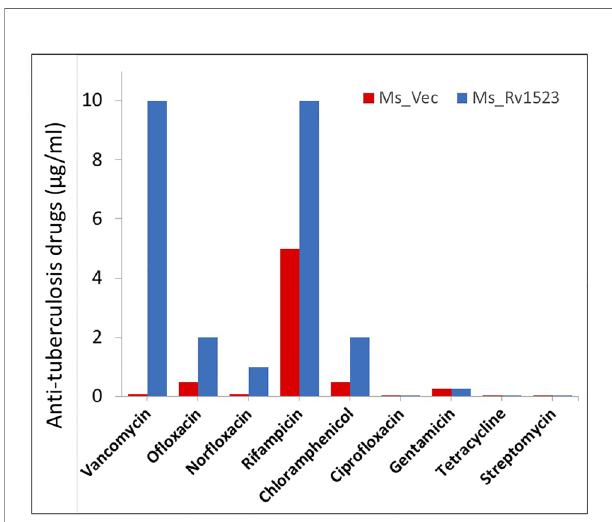
FIGURE 3 | Ms_Rv1523 was resistant to anti-tuberculosis drugs. Recombinant Ms_Rv1523 and Ms_Vec were treated with nine anti- tuberculosis drugs and MIC of nine antibiotic was detected. The MIC values of O fl , Rif, Van, and Nor for Ms_Vec were 0.5 m g/ml, 5 m g/ml, 0.1 m g/ml, and 0.01 m g/ml while 2 m g/ml, 10 m g/ml, 10 m g/ml, and 0.1 m g/ml for Ms_Rv1523, respectively. The MIC values of Ms_Rv1523 for Van and Nor were 100 and 10 fold higher than Ms_Vec,